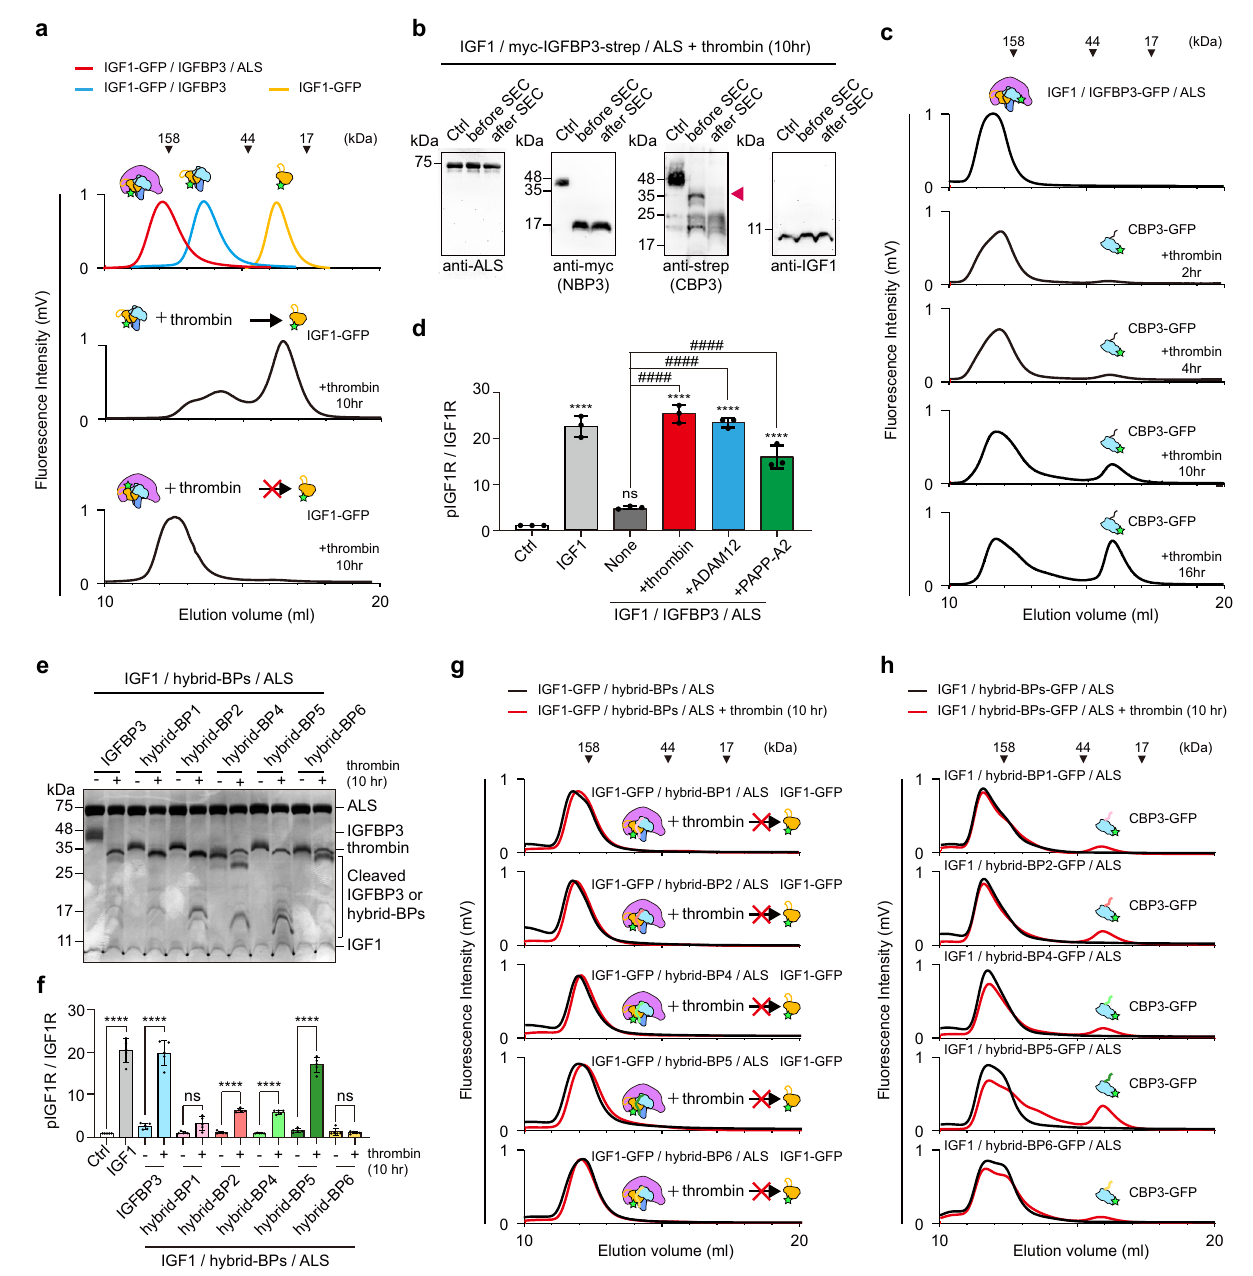
Fig. 6 | Release of CBP3 from the ternary complex after CLD3 proteolysis. a Fluorescence-detection size-exclusion chromatography (FSEC) of binary or ternary complexes after 10h proteolysis by thrombin. The elution pro fi le for standard IGF1-GFP (yellow), IGF1-GFP-strep/IGFBP3 binary complex (blue), and IGF1-GFP/IGFBP3/ALS-His ternary complex (red) are indicated as a control (top). b Immunoblot analysis of IGF1/myc-IGFBP3-Strep/ALS complex after 10h proteo- lysisbythrombinandsubsequentSEC.Anti-mycandanti-Strepantibodywereused to detect NBP3 and CBP3, respectively. No-thrombin treatment served as negative control (Ctrl). c FSEC of the ternary complex (IGF1/IGFBP3-GFP/ALS-His) after thrombindigestionforindicatedtime.Fluorescencesignal(GFP)wasmonitoredto examine the dissociation of CBP3 from the ternary complex. d Quanti fi cation of immunoblot analysis for IGF1R phosphorylation after treatment of intermediate ternarycomplex.HEK293AcellsweretreatedwithIGF1-His(5nM,positivecontrol), IGF1-His/IGFBP3/ALS ternary complex (5nM, none), or intermediate ternary com- plex(5nM).Theintermediateternarycomplexwaspreparedbyproteasedigestion (thrombin, ADAM12 and PAPP-A2) and subsequent SEC puri fi cation. No treatment was used for negative control (Ctrl). Data from three independent